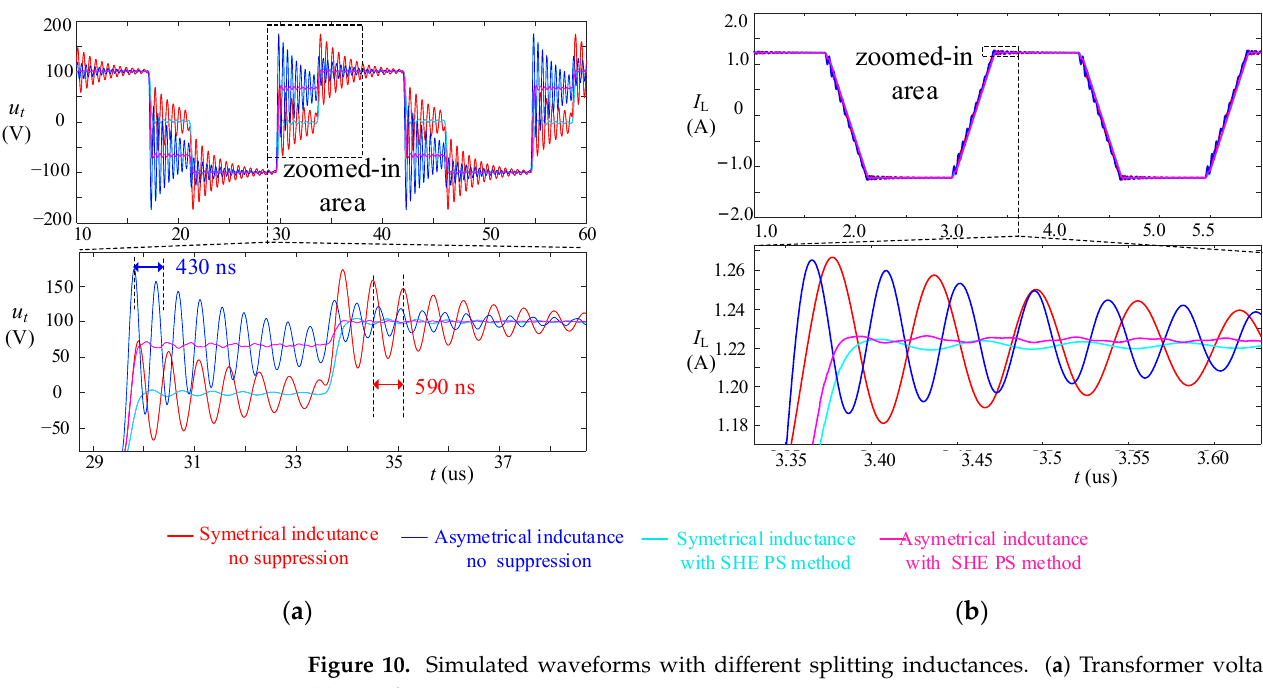
Figure 10. Simulated waveforms with different splitting inductances. ( a ) Transformer voltage; ( b ) transformer current. 4.4. Comparison with Other Suppression Methods The proposed active method was from the perspective of the excitation source. The comparisons between the proposed method and the existing methods in the literature [8– 13] are listed in Table 2. The existing methods in [8–12] are passive methods. For [8,9], external capacitors were connected in parallel with the drain and source of the MOSFET to modify the d v /d t of the AC voltage of the bridges, which limited the switching speed of the devices. Addi ‐ tionally, the analytical model in [8] was based on the symmetrical parameters with the same two phase ‐ shift inductors on the primary and secondary sides, respectively. On the contrary, the model in this article considered the asymmetrical parameters. In practice, the parameters for the MAB were not always symmetrical for the different branches.